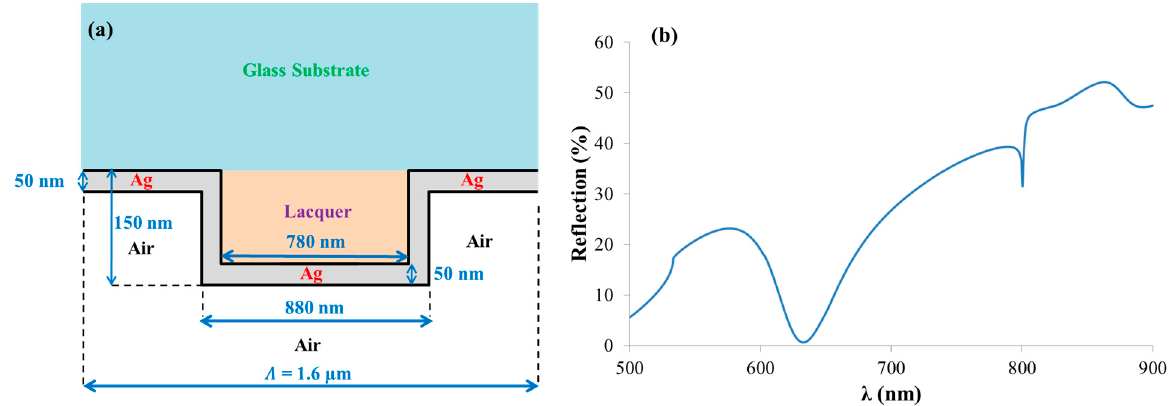
Figure 17. ( a ) Schematic diagram of the structure used in the reflection spectra simulation shown in ( b ). TM-polarized light and normal incidence were used in the simulation.